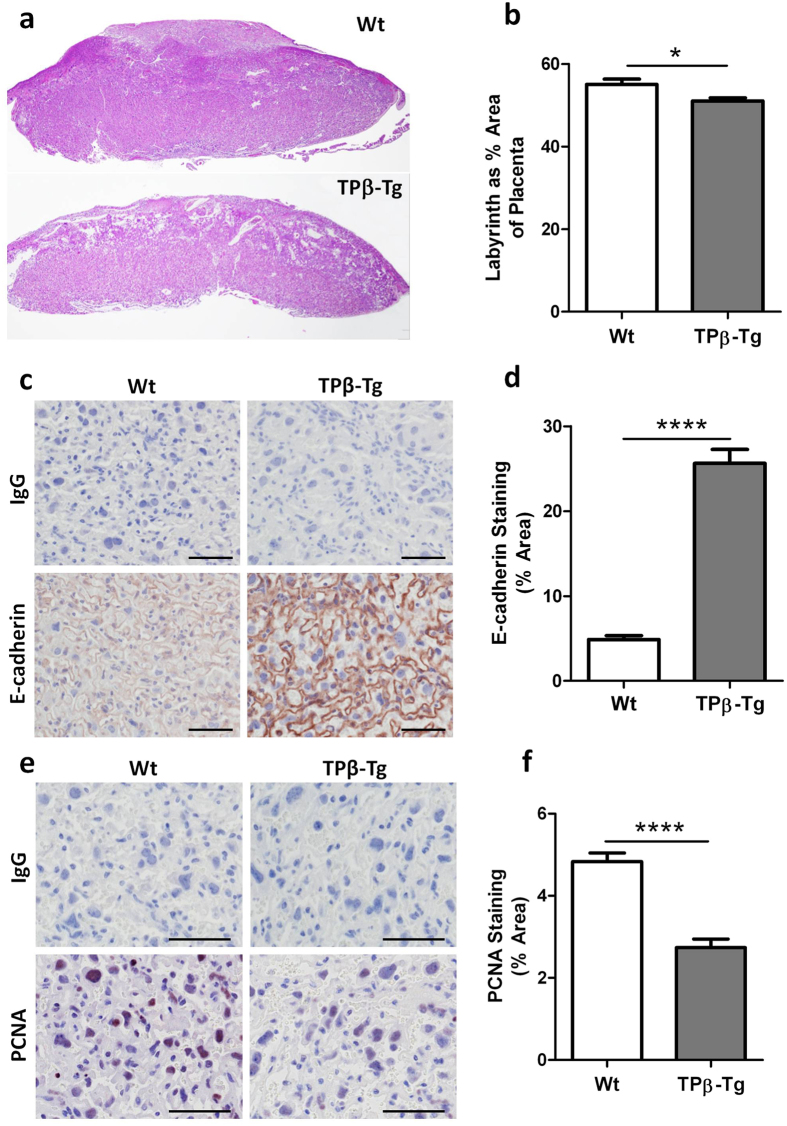
TPβ expression in mice reduces labyrinthine formation and prevents trophoblast proliferation and differentiation as part of the IUGR phenotype.(a) Representative images of H&E stained sections of placentae from pups born to Wt (n = 89) and TPβ-Tg (n = 48) dams at day 18.5 of gestation. (b) From the H&E stained sections, the size of the labyrinthine zone of placentae from pups (n = 9) born to Wt (□) dams and pups (n = 31) born to TPβ-Tg () dams was elucidated using ImageJ software. Representative images (c) and quantification (d) of E-cadherin expression in the labyrinthine zone in placentae from pups (n = 47) born to Wt (□) dams and pups (n = 59) born to TPβ-Tg () dams. Representative images (e) and quantification (f) of proliferation (PCNA staining) in the labyrinthine zone in placentae from pups (n = 53) born to Wt (□) dams and pups (n = 59) born to TPβ-Tg () dams. All sections stained for E-cadherin and PCNA were imaged at 200x magnification, scale bar: 100 μm. The data are represented as mean ± SEM. Independent samples T-test, *P < 0.05, ****P < 0.001.